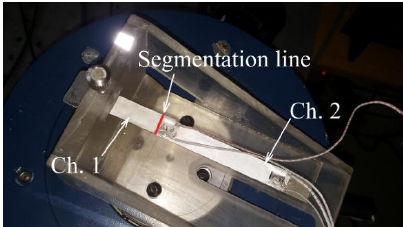
Figure 11. Experimental setup of the tested piezoelectric vibration energy harvester. Sensors 2015 , 15 , page–page